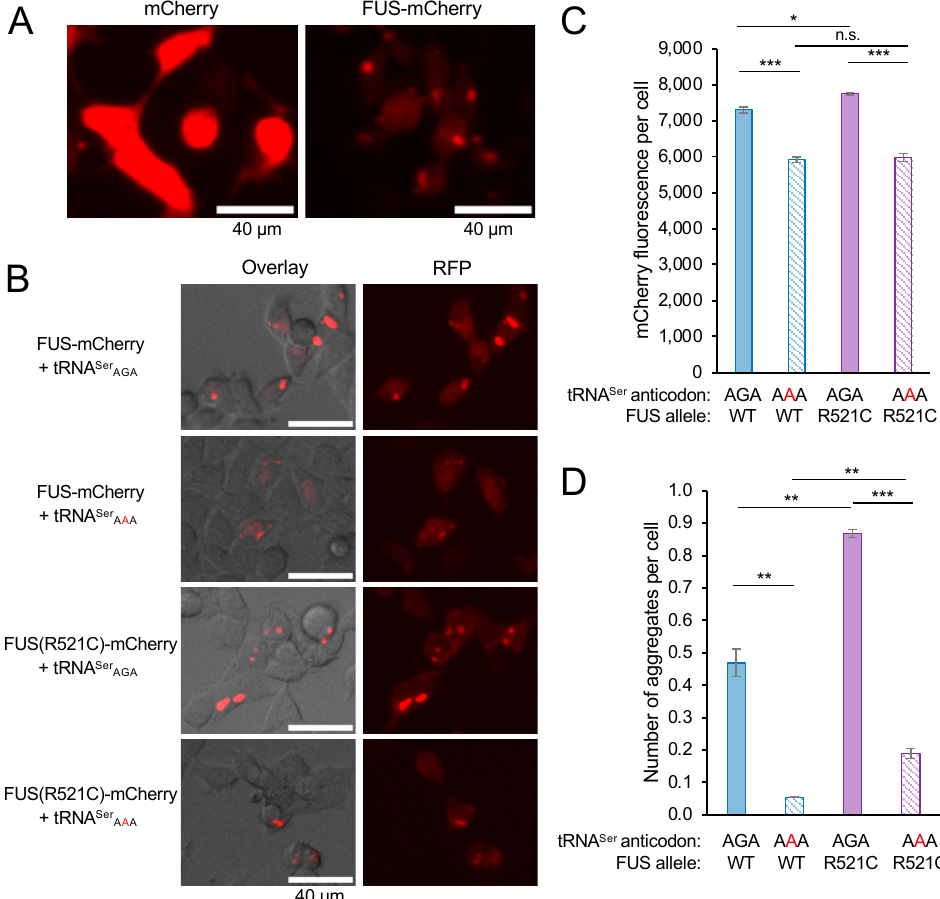
Figure 3. FUS-mCherry aggregates in N2a cells and in HEK 293T cells expressing wild-type or mistranslating tRNA. ( A ) N2a cells expressing mCherry (and no additional tRNA) show diffuse fluorescence well-distributed in the cells, while the cells expressing FUS-mCherry (and no additional tRNA) show dimmer and diffuse fluorescence throughout the cells, as well as clearly defined foci representing FUS aggregates. ( B ) At 24 h after transfection, representative images of HEK 293T cells co-expressing human tRNA SerAGA or G35A variant (tRNA SerAAA ) and FUS-mCherry or FUS R521C-mCherry were captured by brightfield imaging overlayed (left) with fluorescence microscopy imaging (RFP; ex. 531 nm, em. 593 nm, right); the FUS-mCherry fluorescence per cell ( C ) and the number of FUS aggregates per cell ( D ) were quantified (see Supplementary Information). Error bars represent the mean ± 1 standard deviation of at least three biological replicates. Significant differences from pairwise independent sample t-tests are indicated (n.s.—not significant, * p < 0.05, ** p < 0.01, *** p < 0.001).